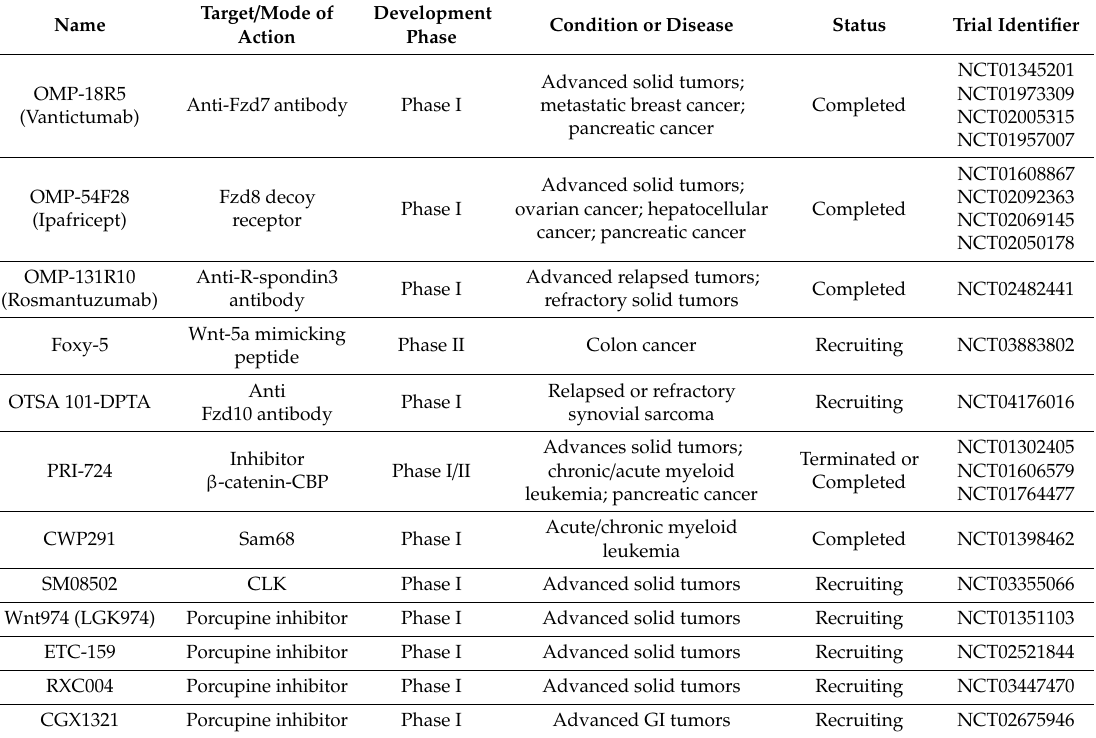
Table 1. Summary of Wnt signaling inhibitors in clinical